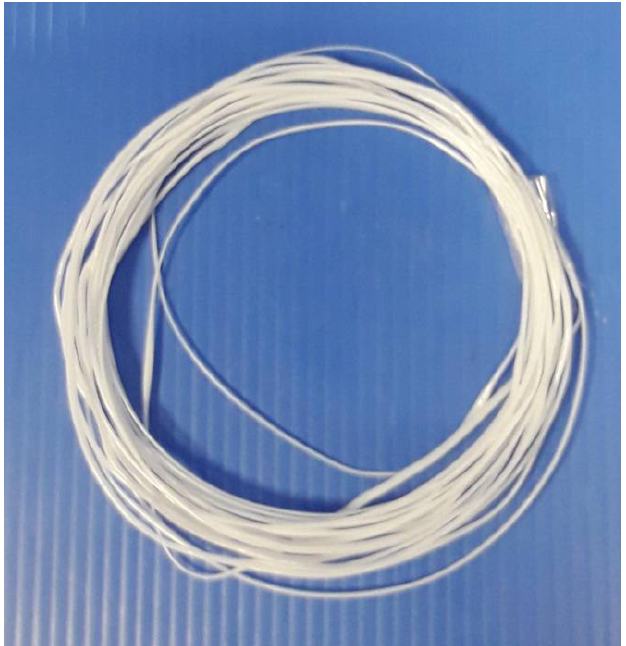
Figure 6. PLA filaments fabricated by recycling material addition ratio of 60%.